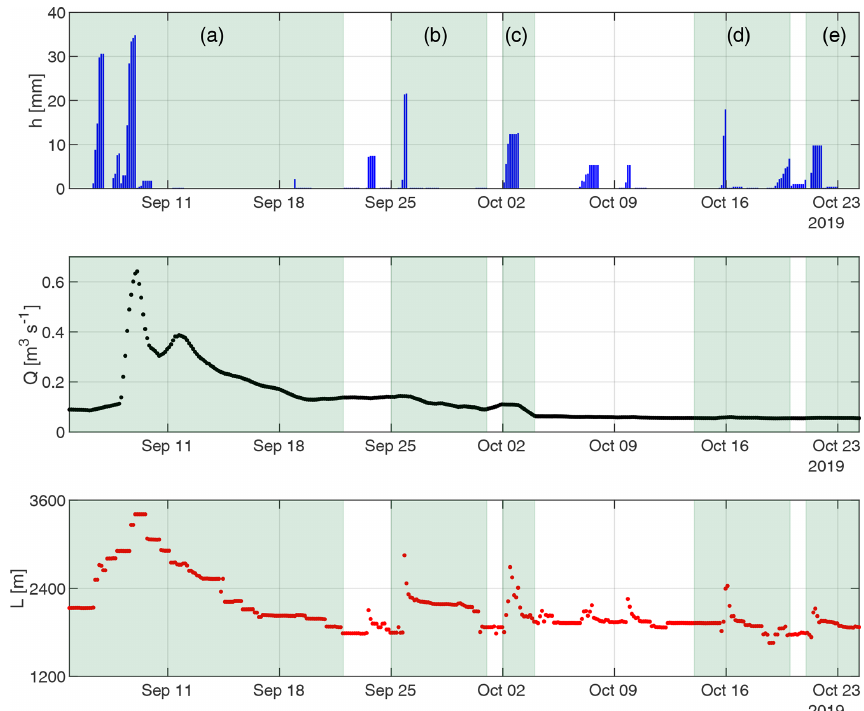
Figure 6. Top panel: temporal evolution of rainfall during the study period. Center panel: temporal evolution of catchment discharge, Q(t) , during the study period. Bottom panel: temporal dynamics of active length, L(t) , during the study period. Areas in green represent the periods during which active length and discharge are plotted in Fig. E1.